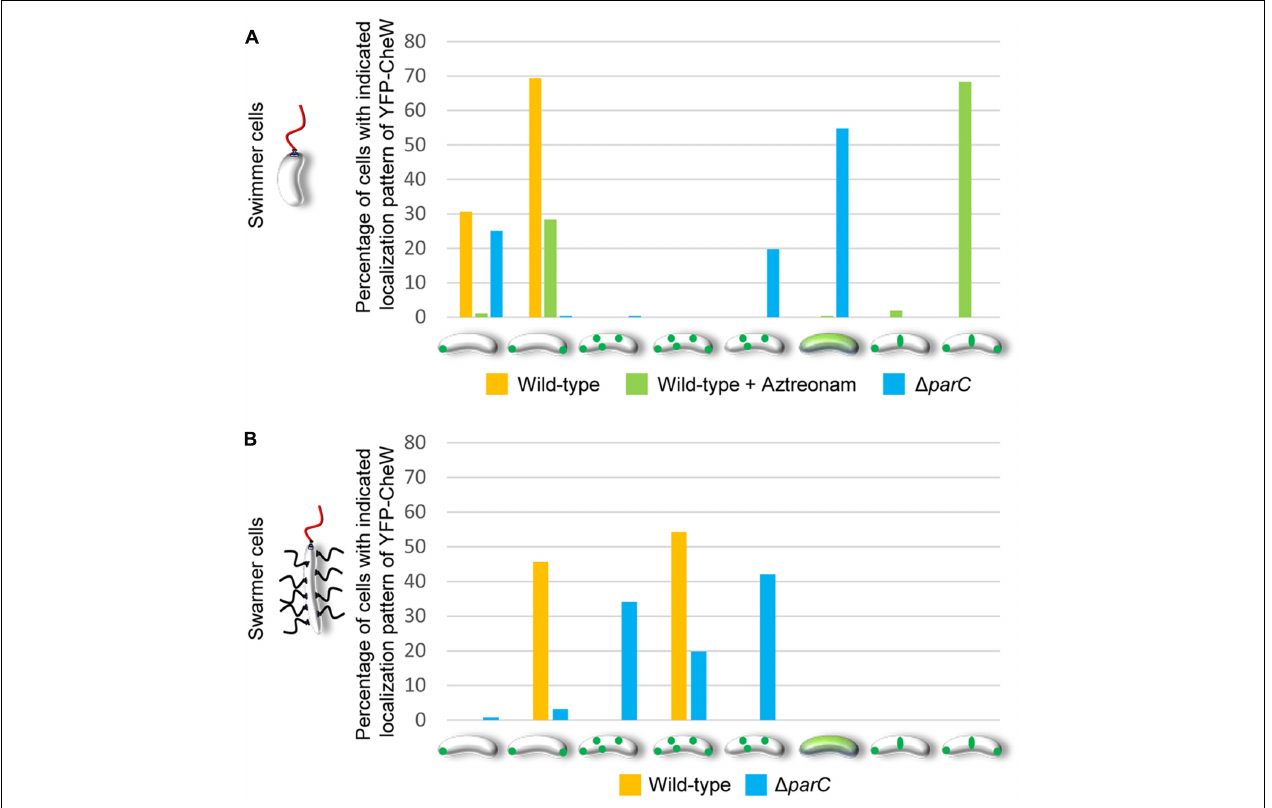
FIGURE 3 | Changes in the intracellular localization of chemotactic signaling arrays during differentiation of V. parahaemolyticus . Localization pattern of YFP-CheW in swimmer (A) and swarmer cells (B) of wild-type, Aztreonam treated swimmer cells, and (cid:49) parC strains of V. parahaemolyticus . Bar graphs show the percentage of cells with the indicated distinct localization patterns. (A) Number of cells analyzed, n : wild-type, n = 298; wild-type + Aztreonam, n = 272; (cid:49) parC , n = 320. (B) Number of cells analyzed, n : wild-type, n = 151; (cid:49) parC , n =